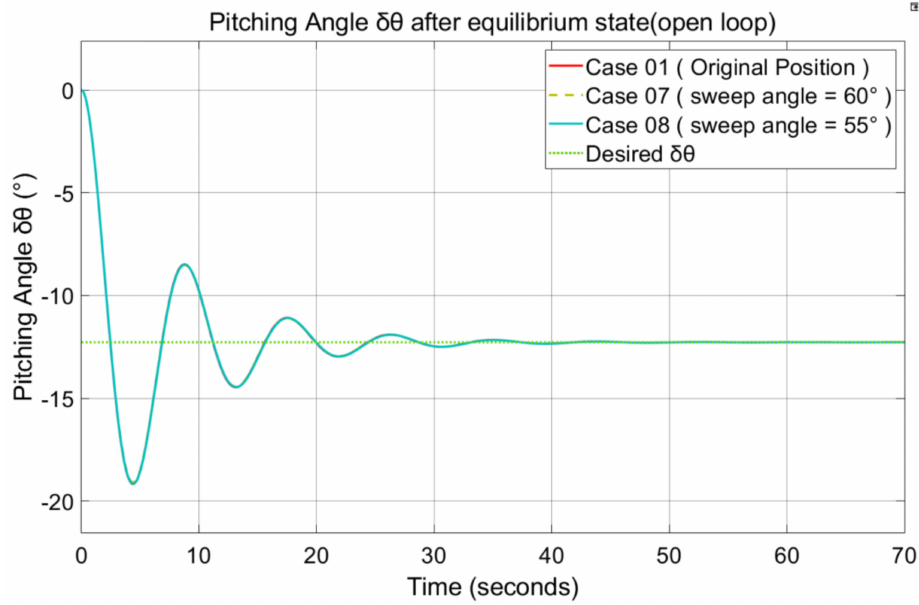
Figure 22. Responses of the pitching Angle ( δθ ) (open loop) (cases 01, 07 and